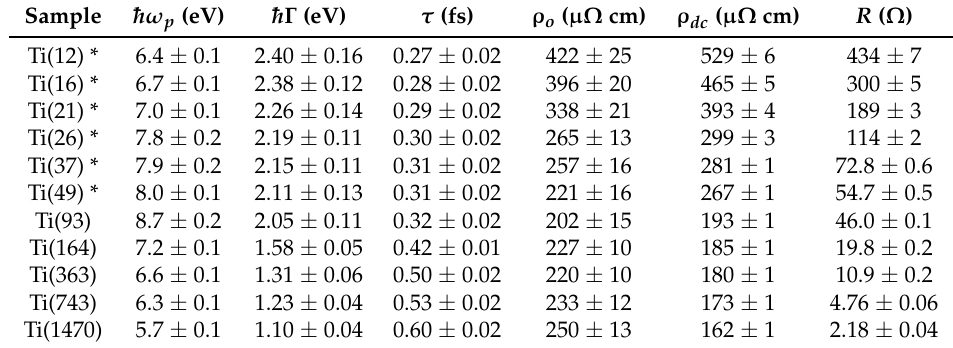
Table 1. Drude parameters (¯ h ω p and ¯ h Γ ), the mean relaxation time of conduction electrons ( τ ), the dc-resistivity ( ρ dc ), the optical resistivity ( ρ o ), and the sheet resistance ( R ) of the Ti layers.